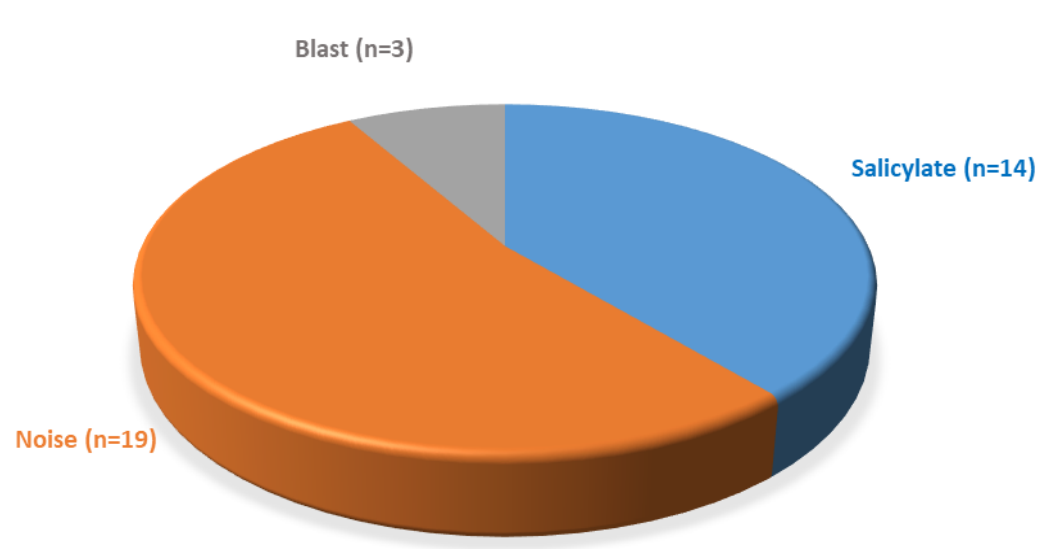
Figure 3. Methods used to induce tinnitus in the selected articles ( n = 36).